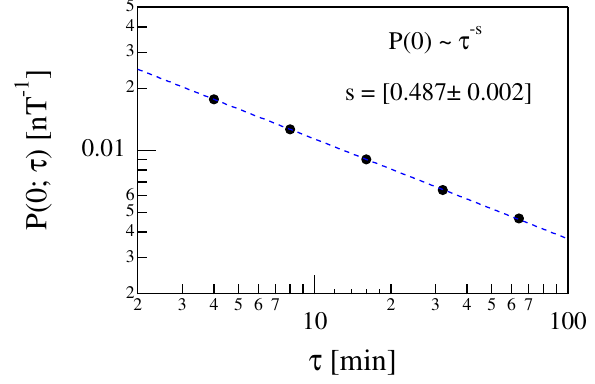
Fig. 3. Collapsing of the PDFs of the AE index increments δAE ( τ ) for τ = 4 , 8 ,..., 64 min, scaled according to Eq.(9). The scaling exponent is s = 0 . 487 . Here P(Y) and Y stand for the scaled PDF and δAE , respectively.